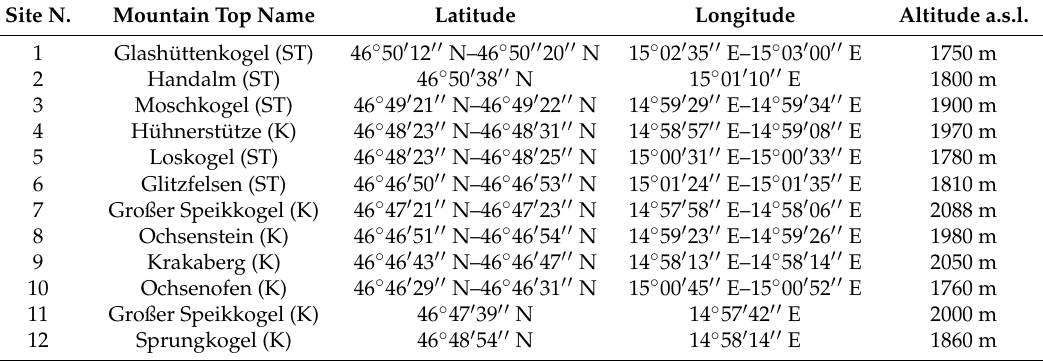
Table A10. Geographic information of the collecting sites is reported: ID number of the site, name of the site, geographical coordinates and altitude. All sites are located in subalpine to alpine habitat above the timberline, ranging between 1800 and 2100 m above sea level (a.s.l.), on the Koralpe Mountain range, in the region Styria (ST) and Carinthia (K) in Austria. Landscape characterized by big boulders and cliffs of homogeneous size of siliceous-schist/gneissic rocks separated by wide areas of pastures or dwarf shrub